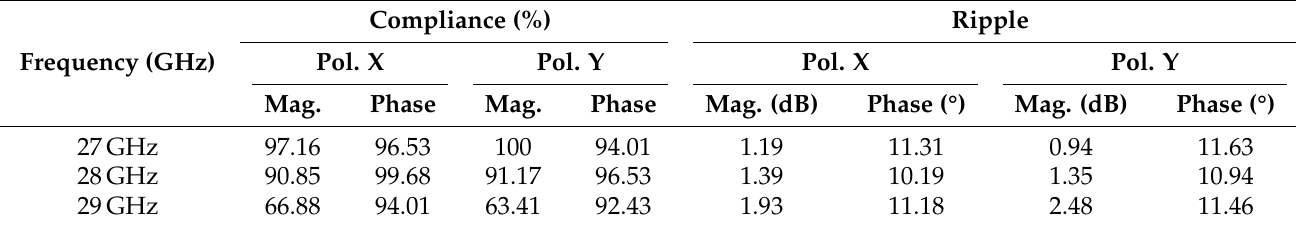
Table 4. Performance of the reflectarray after wideband multi-frequency optimization at a plane 0.5m away from the antenna employing a multi-frequency version of the technique used in [28] with specifications imposed by upper and lower templates. Compliance (%) indicates percentage of surface in Ω 1 that complies with